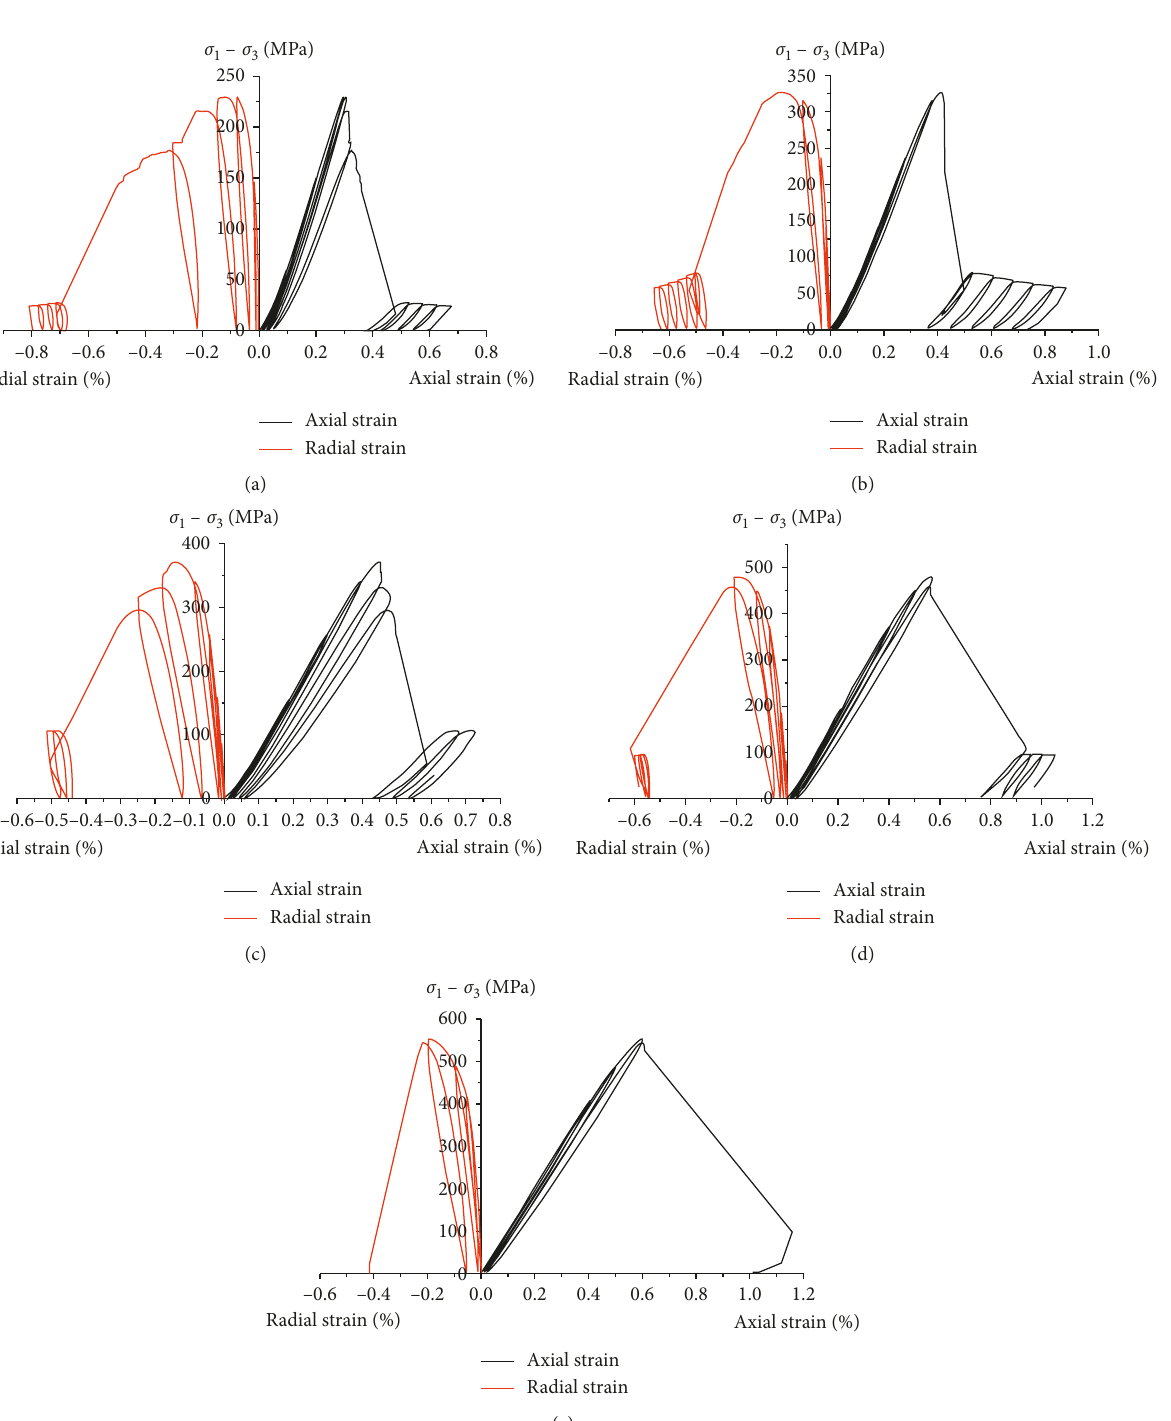
Figure 3: Stress-strain curve of deep rock under different confining pressures in triaxial cyclic loading-unloading tests: (a) 1MPa; (b) 5MPa; (c) 10MPa; (d) 20MPa; (e)